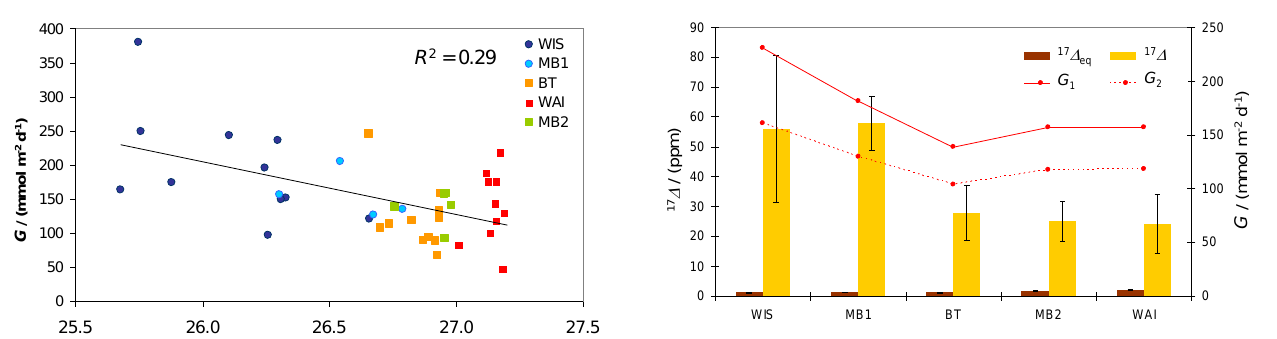
Fig. 9. Average 17 O excess ( 17 ∆) (yellow bars, left axis) and G (red lines, right axis) in five areas in the Bellingshausen Sea. Brown bars represent the average 17 O excess at equilibrium with the at- mosphere ( 17 ∆ eq ) , calculated from in situ temperatures (Luz and Barkan, 2009). Two different sets of parameters have been used to calculate G 1 and G 2 (see main text for